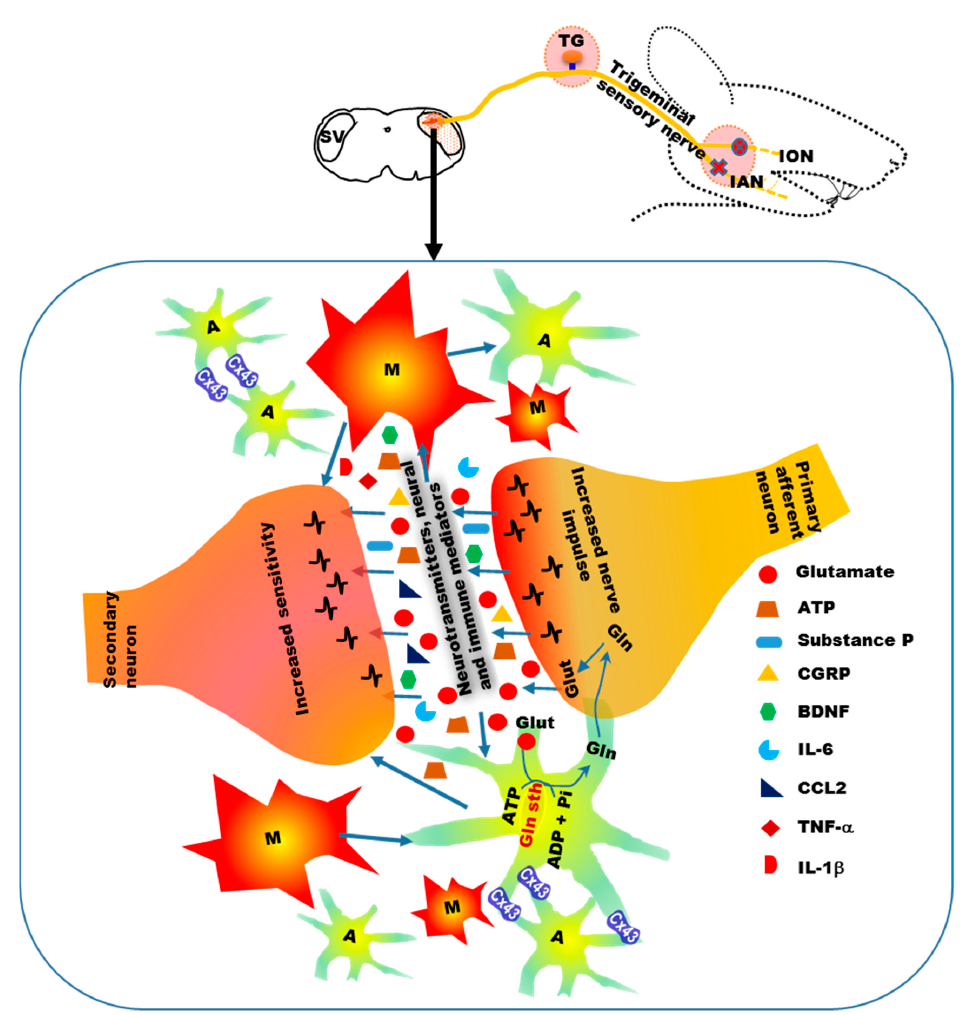
Figure 3. Glial cell involvement in sensory nuclei participates in the development of neuropathic pain. Microglia and astroglia are activated and proliferated in the brainstem sensory nuclei of the trigeminal nerve. Increased primary afferent input following nerve injury causes the release of neurotransmitters and neural and immune mediators, which increase the sensitivity of postsynaptic secondary neurons and activate glial cells. Upon activation, glial cells release mediators (such as ATP, IL-1 β , TNF- α and BDNF) that act on secondary neurons and increase their sensitivity. Glutamate–glutamine shuttle activity between astroglia and neurons is increased following nerve injury, thereby increasing the glutamate supply in the synapses between primary and secondary neurons. Cx43 expression increases in astroglia following trigeminal nerve injury, indicating increased communication among the astroglial cells. ATP: Adenosine triphosphate; CGRP: Calcitonin gene-related peptide; BDNF: Brain derived neurotrophic factor; IL-6: Interleukin 6; CCL2: Chemokine ligand 2; IL-1 β : Interleukin 1 beta; TNF- α : Tumor necrosis factor alpha; A: Astroglia; M: Microglia. Infiltration of CD4 (cluster of differentiation 4)-positive T-cells into the spinal cord is observed after spinal nerve transection [88,89]. Infiltration of macrophages or monocytes into the spinal cord occurs following partial sciatic nerve ligation, and these cells can differentiate into microglial-like cells [95]. Astroglia are activated subsequent to microglial activation [16,19,92]. Enhanced neuronal activity after peripheral nerve injury can activate both astroglia and microglia (Figure 3) [16,19,92,96]. Inhibition of nerve injury-induced neuronal activity reduces astroglial marker (GFAP) expression in the spinal cord [96]. Upregulation of GFAP is also observed in the spinal trigeminal complex